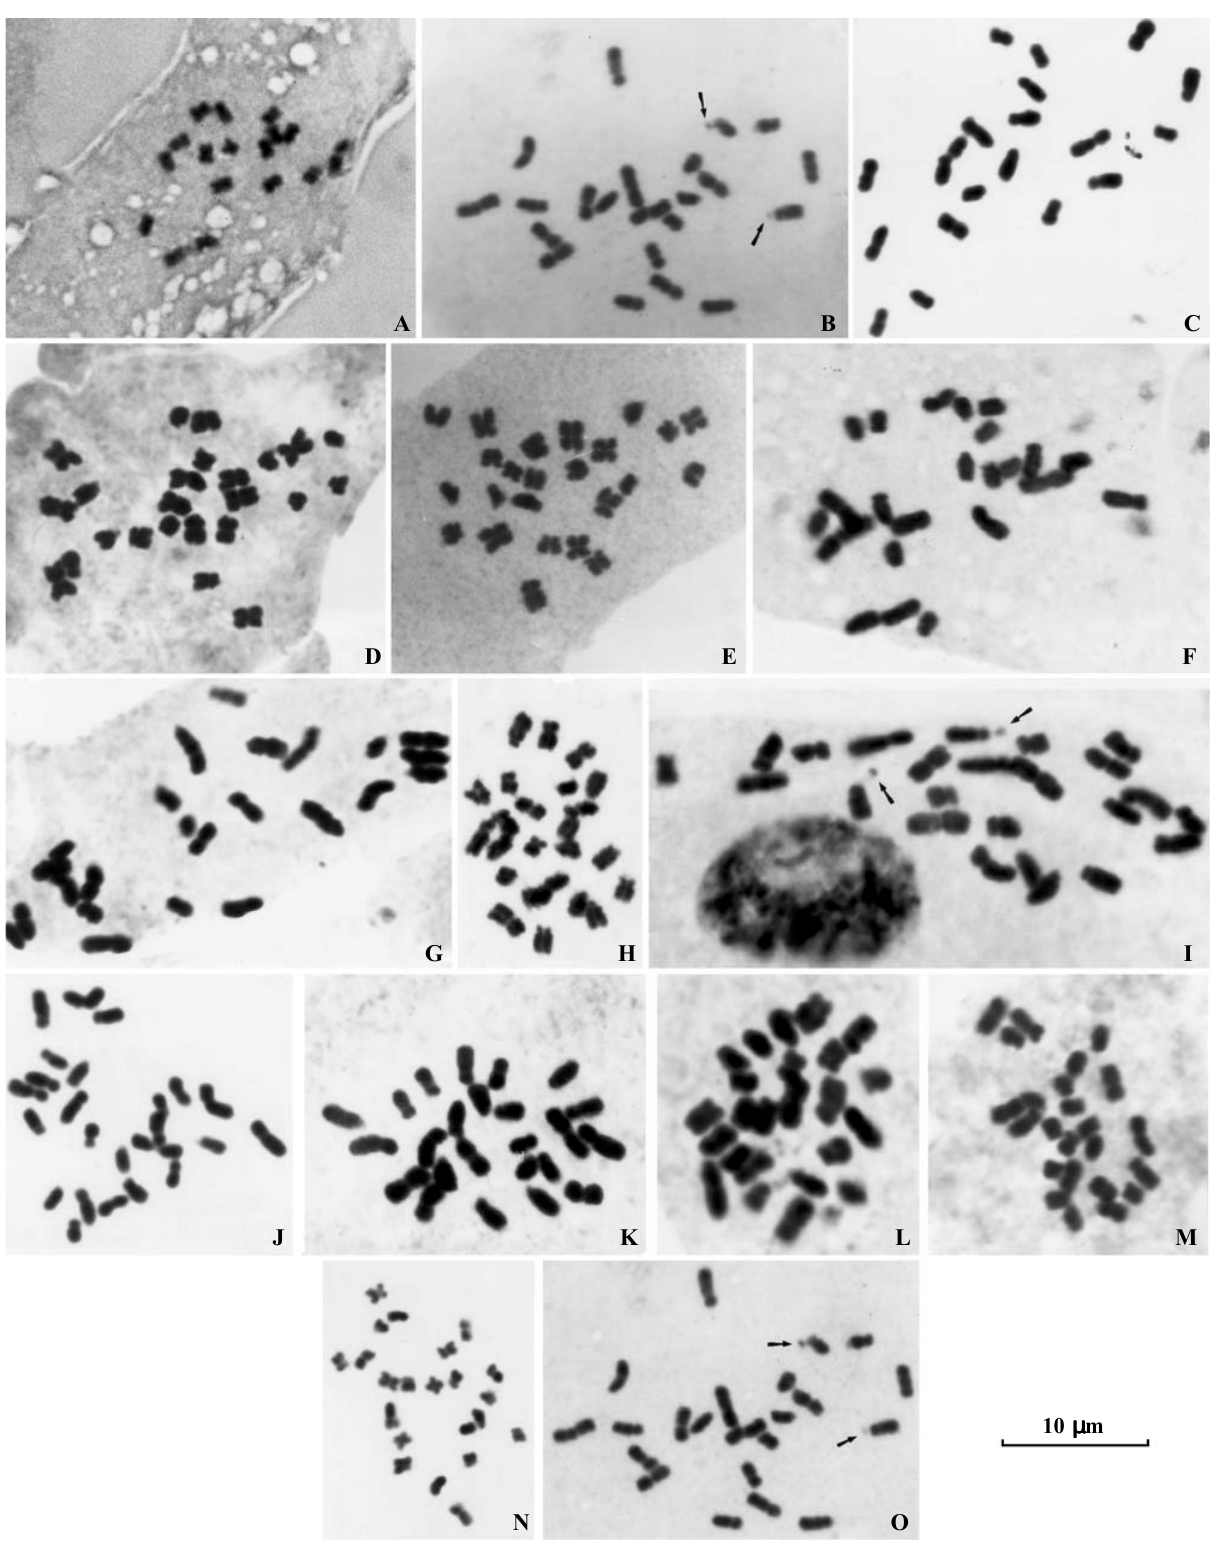
Figure 1 - Somatic chromosomes of Sapindaceae, Paullinieae. A : Cardiospermum anomalum , 2n = 18. B : C. corindum , 2n = 22. C : C. grandiflorum , 2n= 20. D : Paullinia coriacea , 2n= 24. E : P. weinmanniaefolia , 2n = 24. F : Serjania acutidentata , 2n = 24. G : S. cissoides , 2n = 24. H : S. communis , 2n = 24. I : S. grammatophora , 2n = 24. J : S. lethalis , 2n = 24. K : S. pernambucensis , 2n = 24. L : S. purpurascens , 2n = 24. M : S. suborbicularis , 2n = 24. N : Urvillea ulmacea , 2n = 22. O : U. chacoºnsis , 2n = 22. Arrows indicate